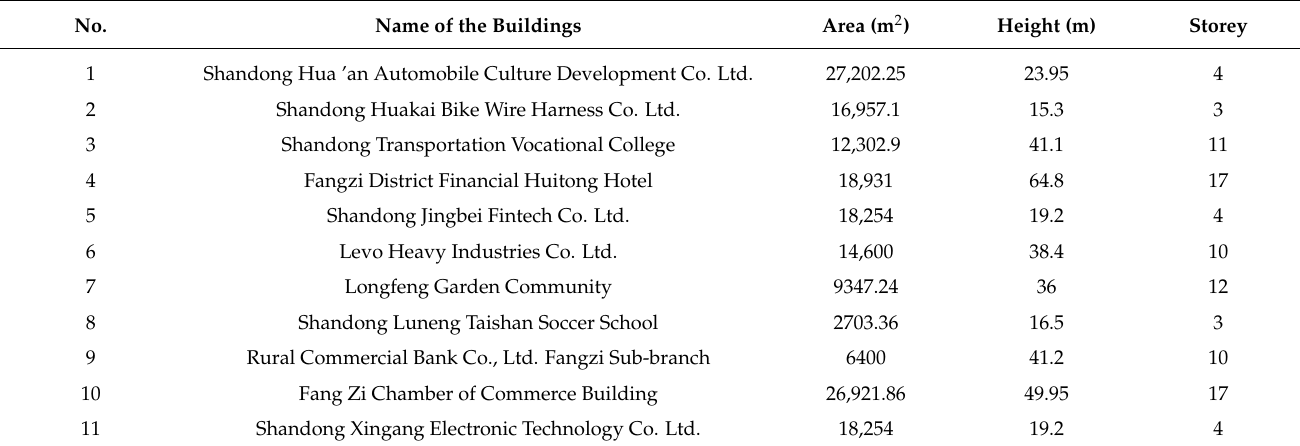
Table A1. The name list of the buildings used in the experiments.